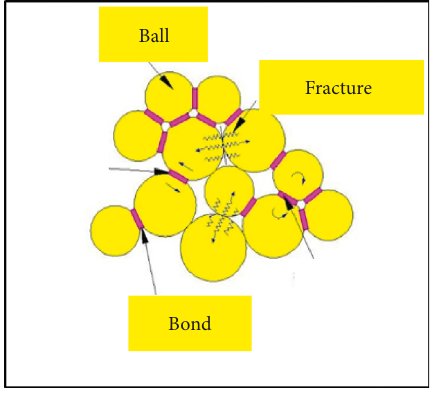
Figure 6: Parallel-bond